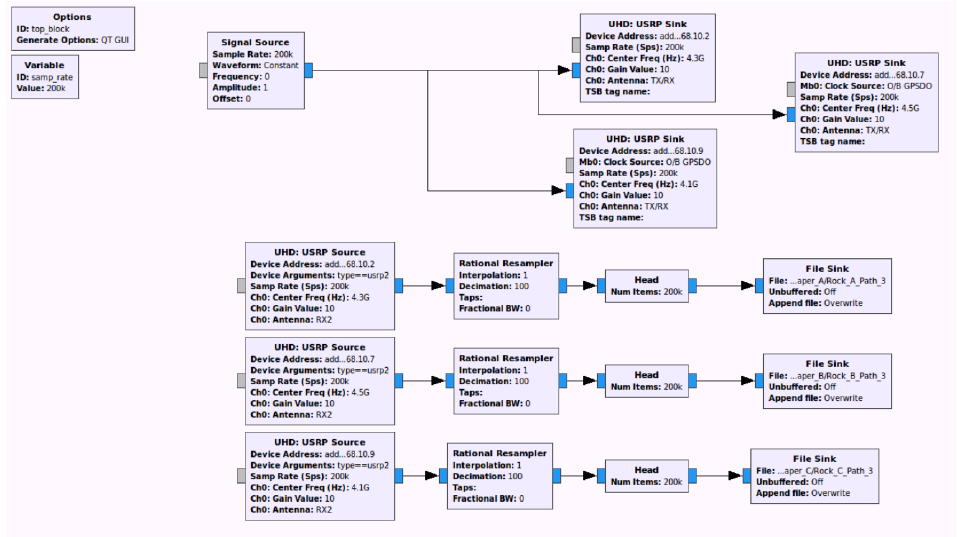
Figure 7. GNU-radio flowgraph for distributed MD